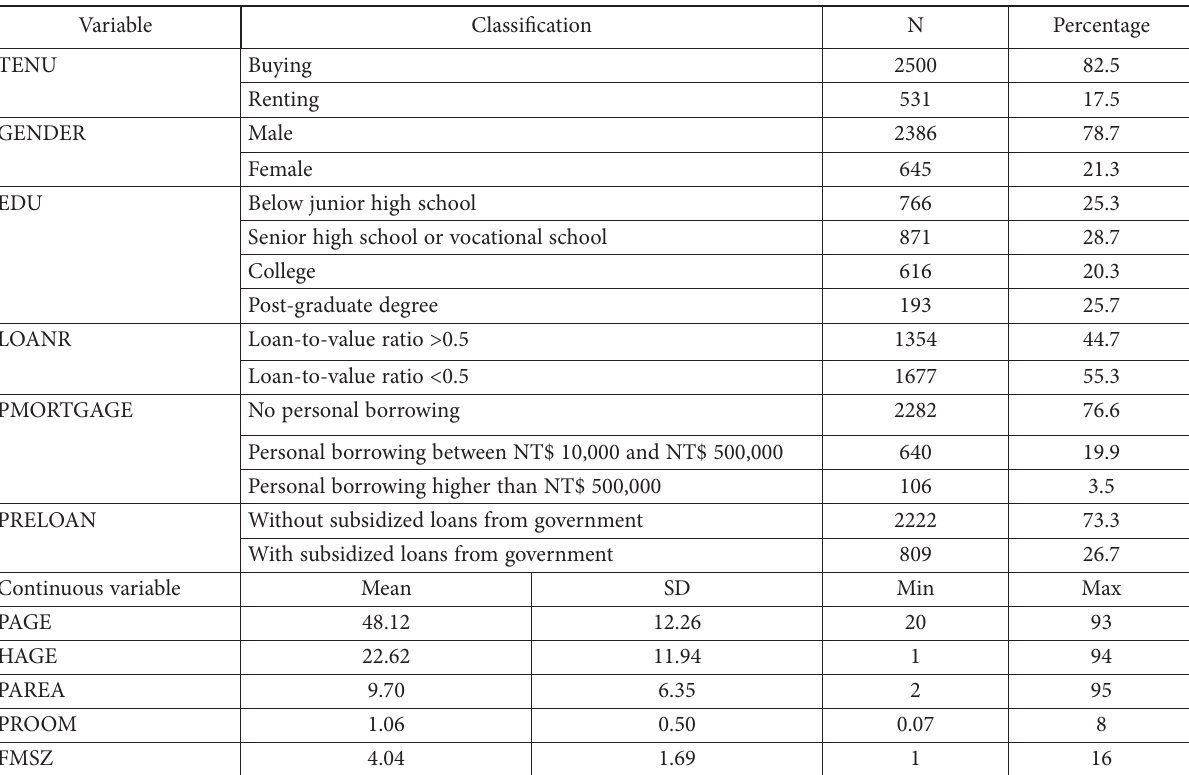
Table 2. Descriptive statistics of first-level variables (N =